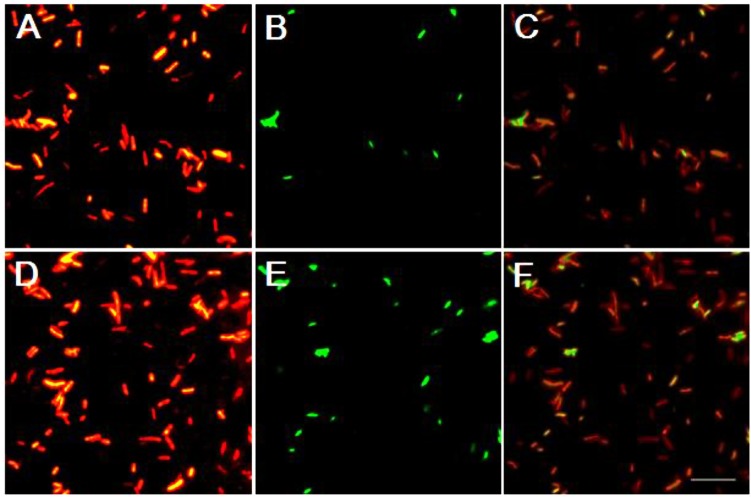
FISH analysis of the two dominant bacterial phylotypes of Epsilonproteobacteria and Bacteroidetes in the intestines of CMC.Every two epifluorescence photomicrographs (A and B, D and E) show the same microscopic field of CMC intestinal sample double-hybridized with oligonucleotide probes specific for Bacteria (Eub338) (A, D) and for Epsilonproteobacteria (EPSY549) (B) or Bacteroidetes (CF319a) (E). (C) Merged photo of A and B. (F) Merged photo of D and E. Scale bar = 10.0 μm.